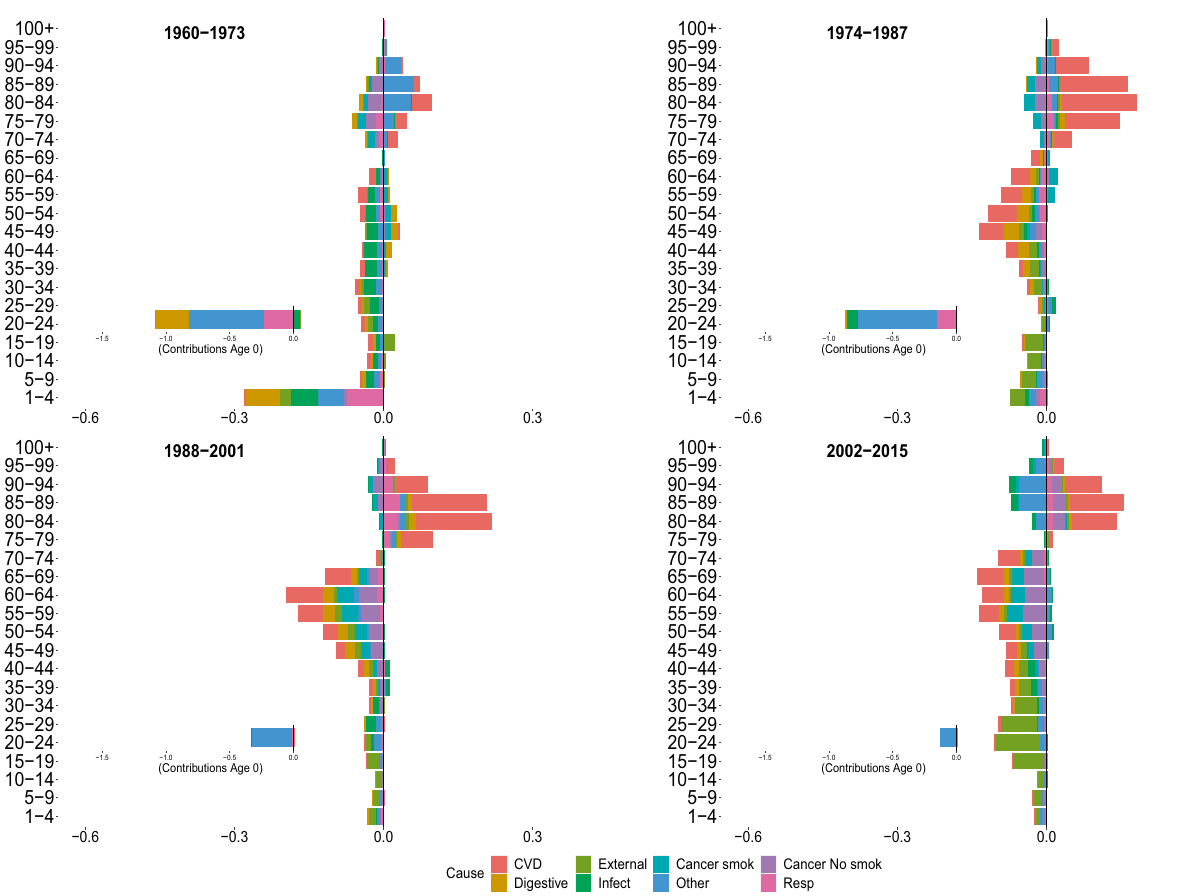
Figure 5. Age and cause contributions to changes in lifespan inequality for Italian males.